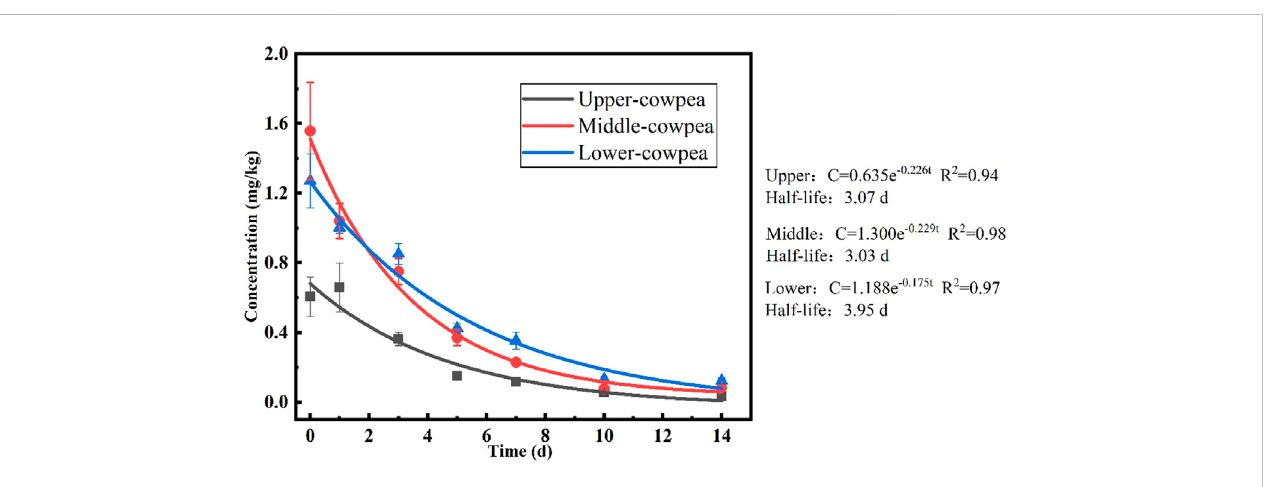
FIGURE 4 Dissipation and half-life of fl uopyram residues in